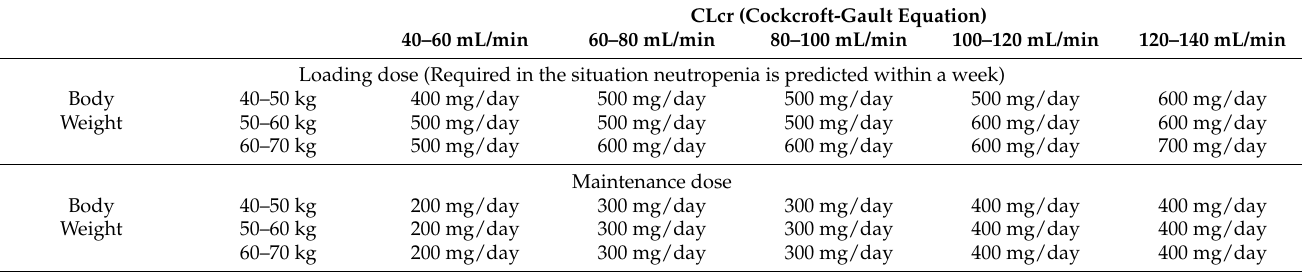
Table 4. Nomogram of fluconazole dose for prophylaxis.